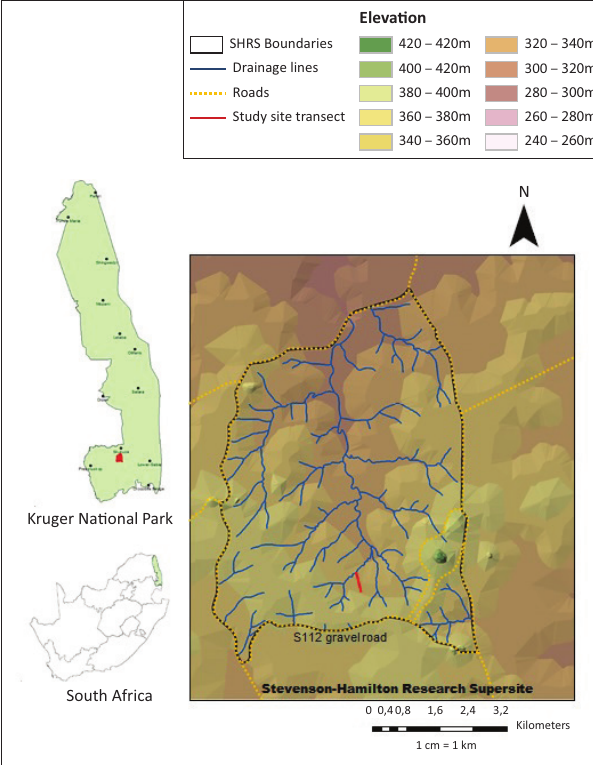
FIGURE 1: Location and elevation (meter above mean sea level) of the study site within Stevenson–Hamilton Research Supersite (SHRS), Kruger National Park, South